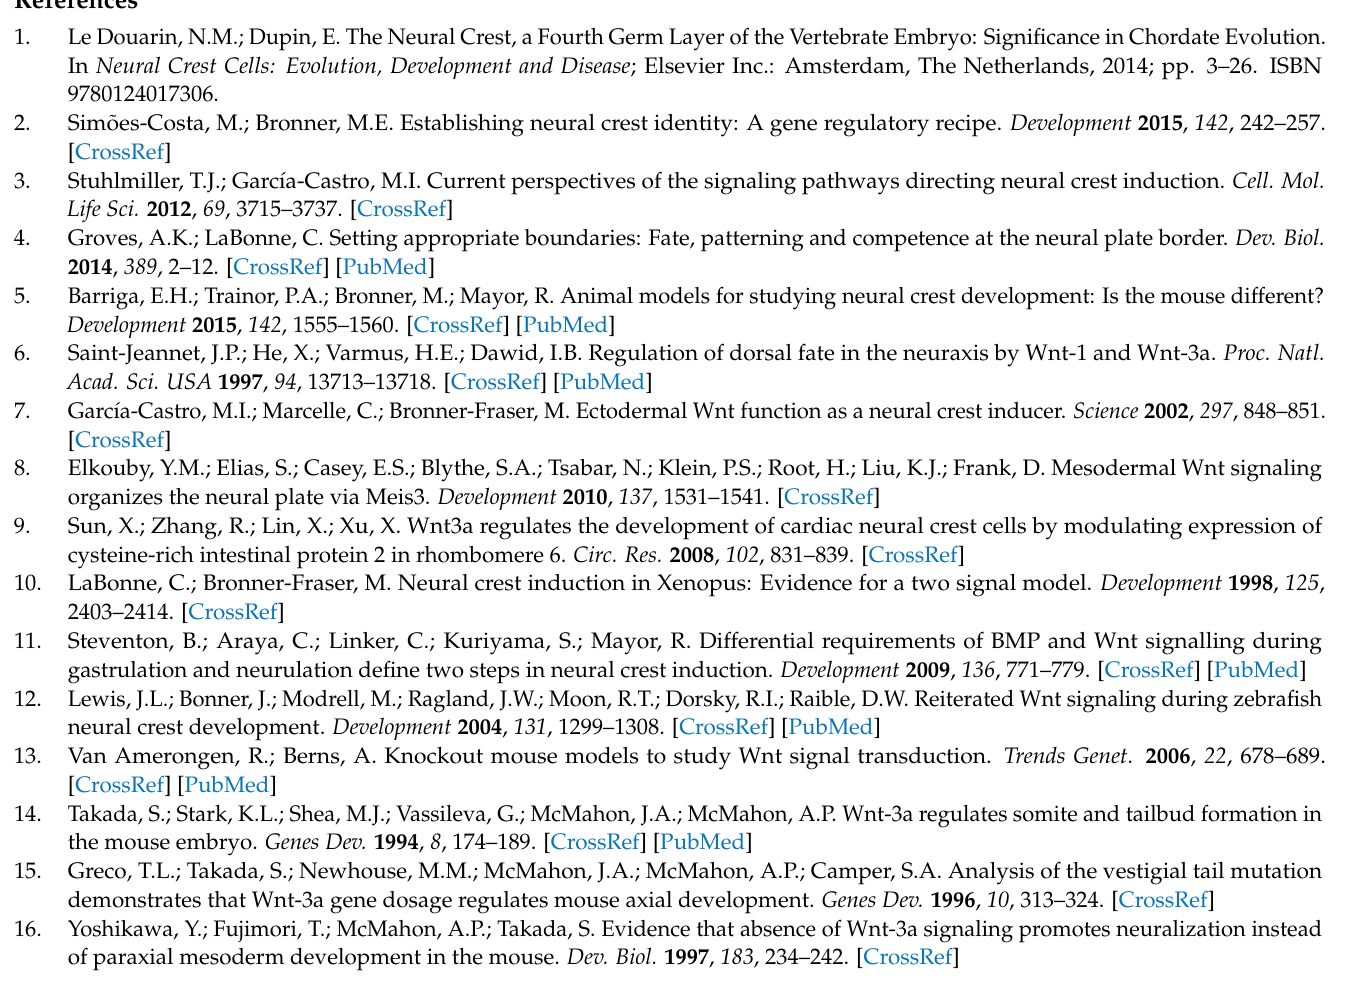
S2: The UFDS system confirms the ZF-NC domain as the sole site of SUMO attachment for ZIC1-4 proteins. Figure S3: SUMOylation does not alter ZIC1 or ZIC4 activation of the Foxd3 enhancer. Figure S4: A ZIC-optimized, TCF-dependent transcription assay. Figure S5: SUMOylation reduces ZIC1 but not ZIC4 inhibition of WNT